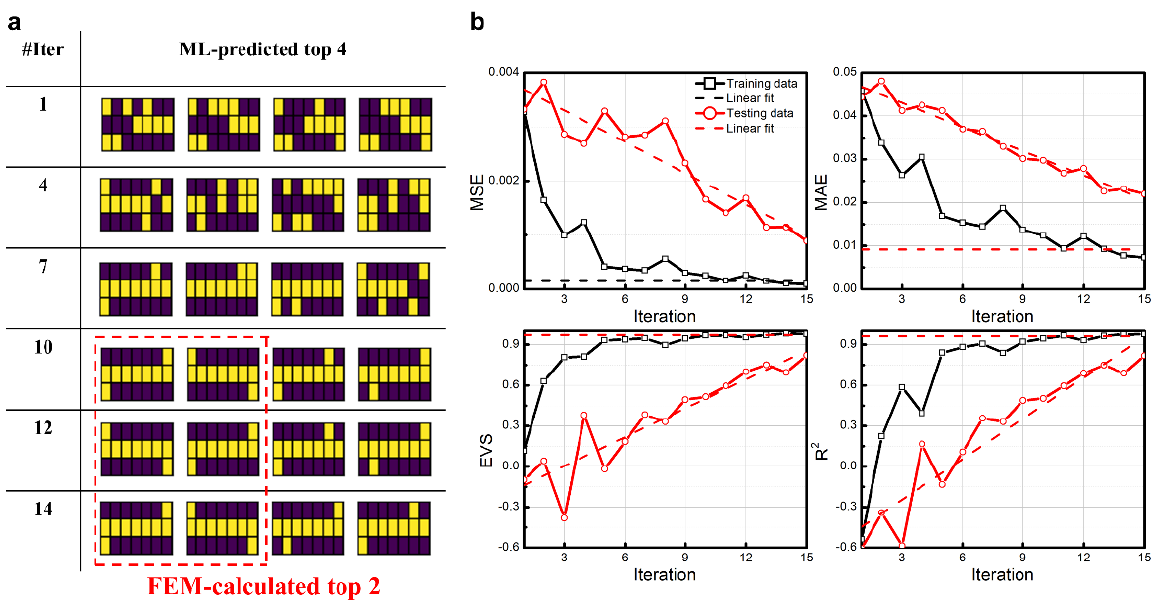
Figure 4. Iterated results and evaluations for the calculation domain discretized into 21 blocks by the proposed LSTM-based optimal strategy. ( a ) Top 4 ML-predicted sample configurations in each iteration. The sample configurations inside the red dashed-lined domain are the FEM-calculated top 2 configurations. ( b ) The relationship between evaluation indictors MSE, MAE, EVS, and R 2 and iteration numbers. Black curves with open rectangles are for the training dataset; black dashed lines mark average values between iterations 11 and 15. Red curves with open circles are for the testing dataset; red dashed lines mark linear fit of red curves between iterations 1 and 15.